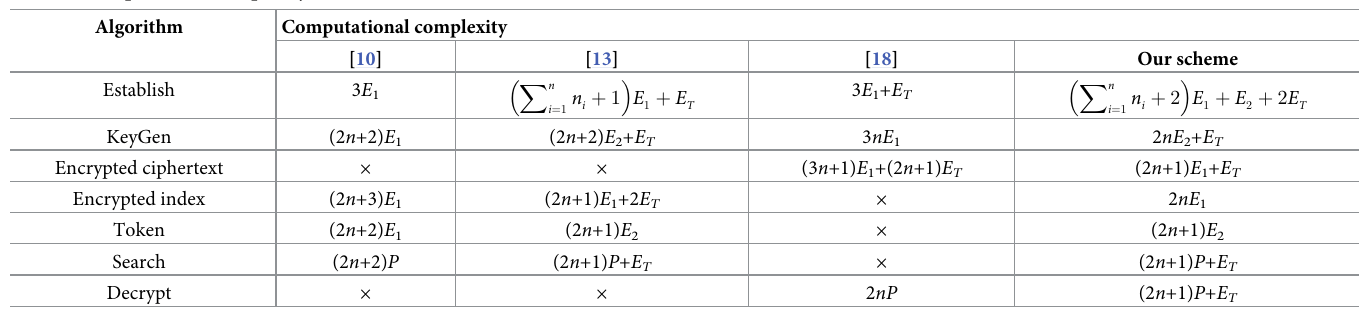
Table 1. Computational complexity. Algorithm